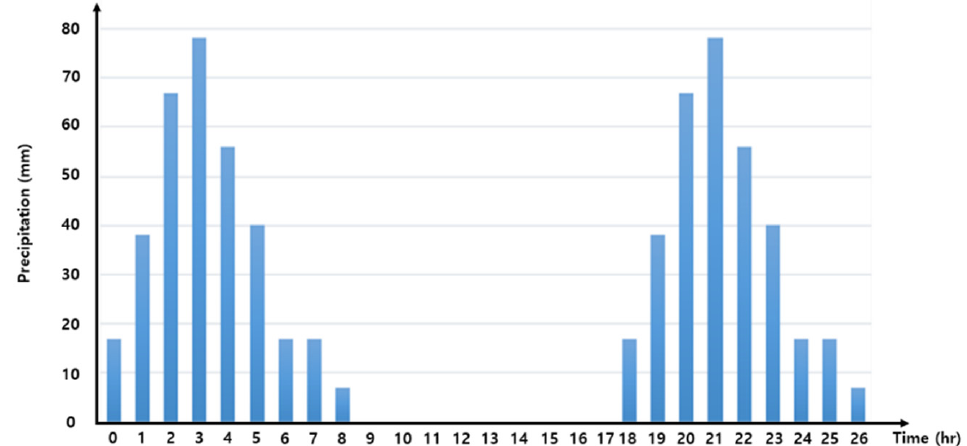
Figure 6. Mega rainfall event scenario using IETD; two 100-year frequency-based rainfall events exist within IETD (9 h).